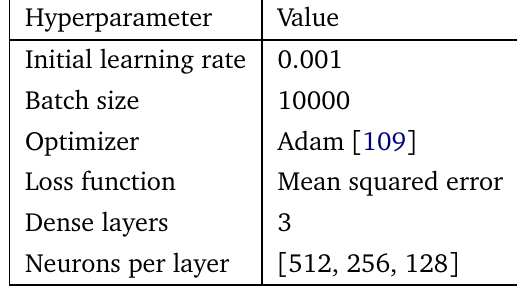
Table 16: Parameter combinations used for training the Deep SVDD models.